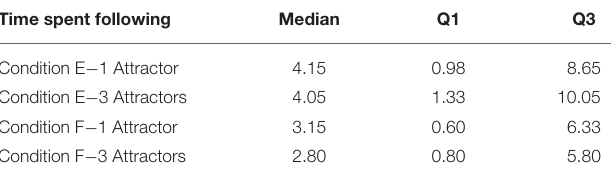
TABLE 6 | Wilcoxon signed-rank test—pressure/tension scores.